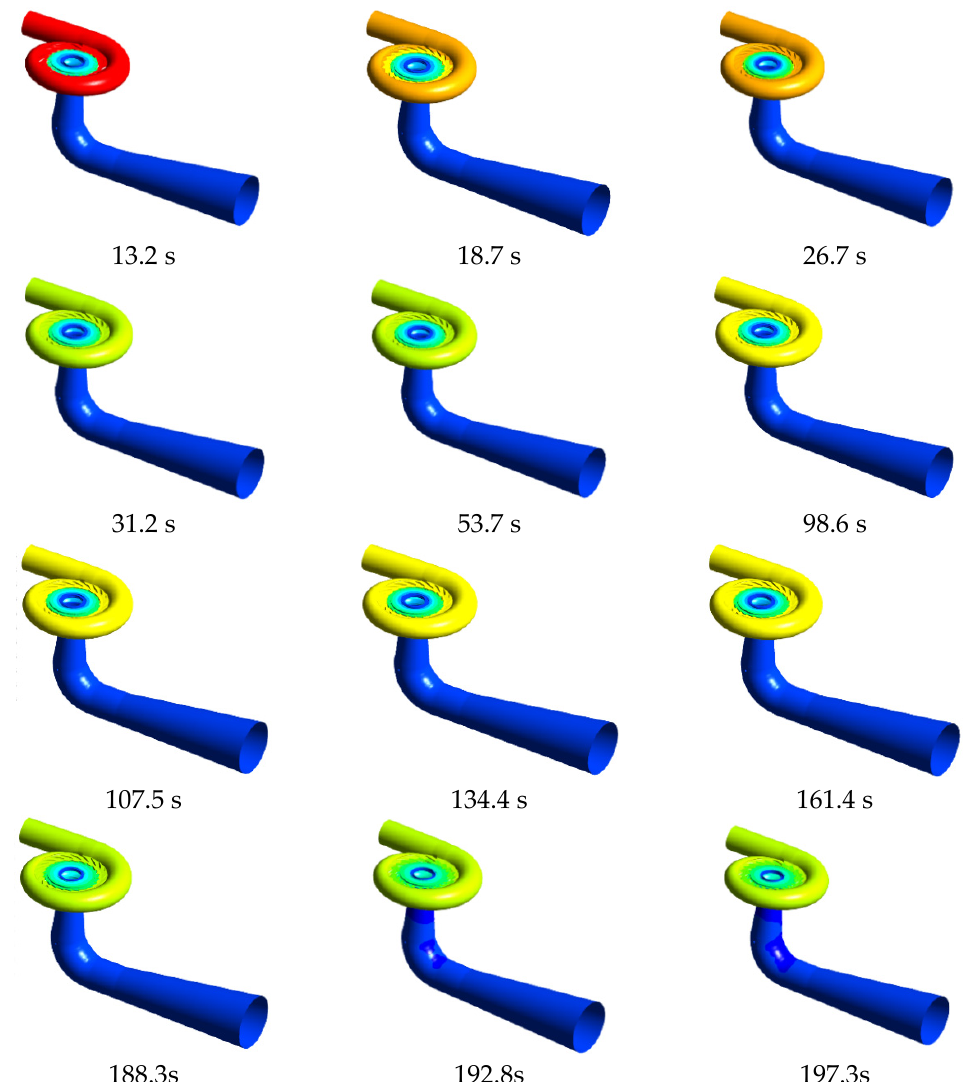
Figure 6. Pressure distribution of the PT flow channel during turbine start-up. It can be seen from Figure 7 that from t = 0 s to t = 13.2 s during turbine start-up as the opening of the guide vanes increases, the flow increases, and the pressure in the area between the stay vanes and the guide vanes also increases. The high-pressure area at the trailing edge of the guide vanes the increases, while the pressure on the runner blade surface also increases. From t = 18.7 s, the high-pressure area on the trailing edges of the guide vanes reduces, and the low-pressure area appears on the blade outlet edge. When the rotating speed of the runner reaches the rated speed, the guide vane will close a little to avoid the over speed. Therefore, from t = 26.7 s on, the pressure in the area between the stay vanes and the guide vanes gradually decreases, the pressure on the trailing edge of the guide vanes decreases, and the low-pressure area on the runner blade outlet increases. After t = 53.7 s, the opening of the guide vane remains constant for a period of time, so the pressure in the channels of guide vanes and runner blades does not change much during this period. From t = 134.4 s to 197.3 s, the opening of the guide vanes increases largely, and the flow velocity increases correspondingly. The pressure in the area between the stay vanes and the guide vanes decreases, and the low-pressure area on the blade surface